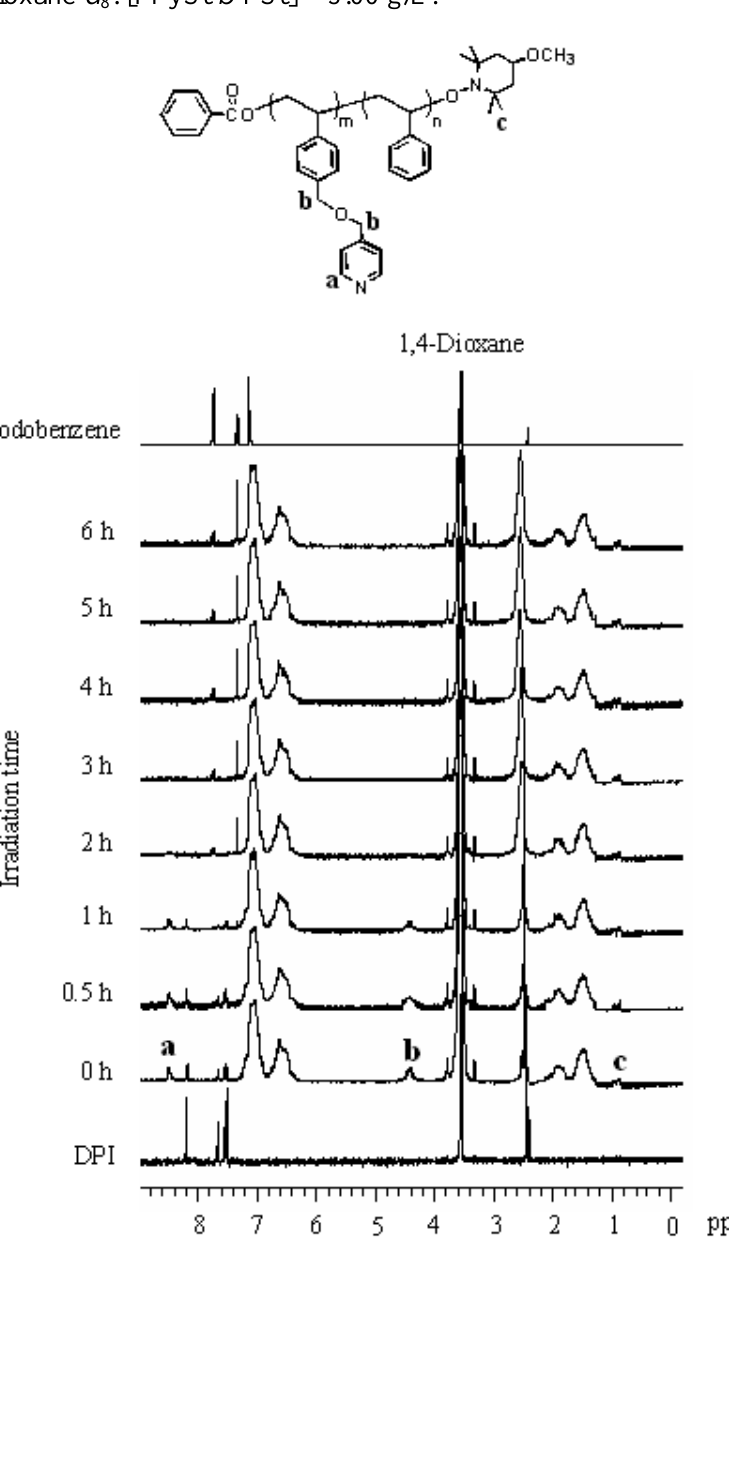
Figure 10. 1 H NMR spectra of the copolymer during irradiation, DPI, and iodobenzene. Solvent: 1,4-dioxane- d . [PPySt- b -PSt] = 3.00 8